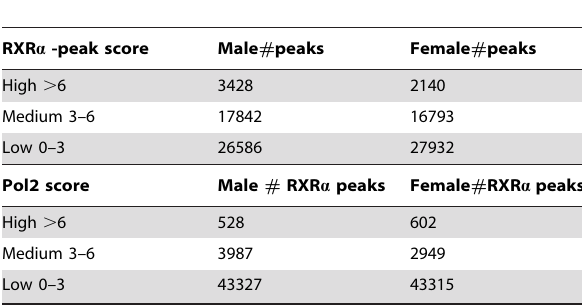
Table 1. Stratification of RXR a binding sites in male and female mouse liver according to binding.